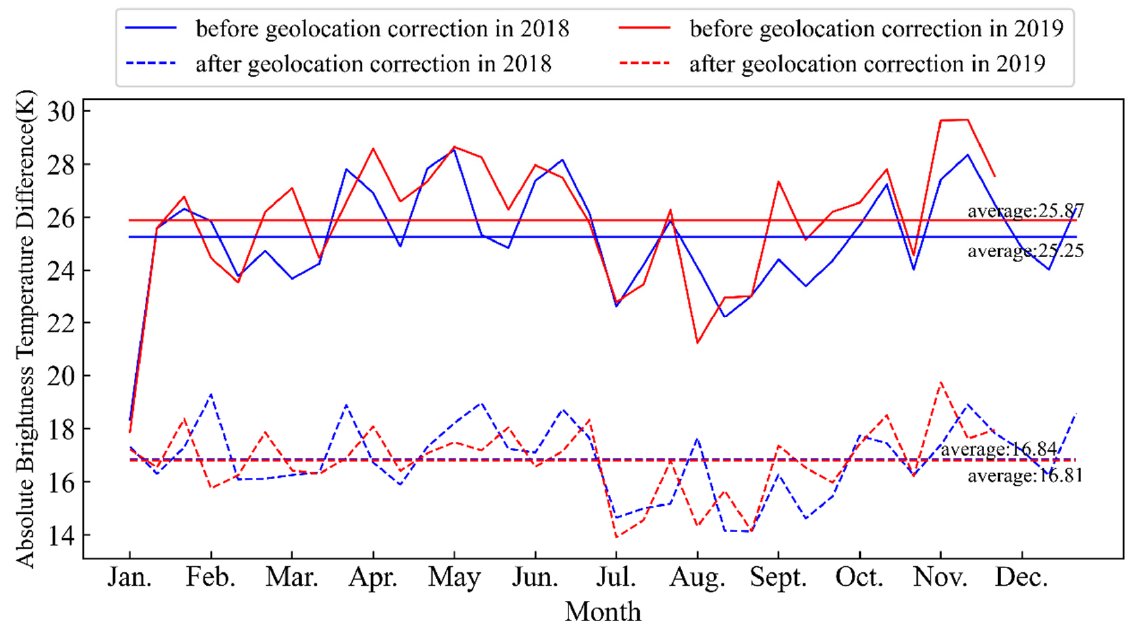
Figure 8. The brightness temperature differences of the MWRI images before and after geolocation correction by SCIM in the first three days of every month from 2018 to 2019. Table 3. Mean brightness temperature differences between MWRI ascending and descending images in the first three days of every month from 2018 to 2019. Before Correction After